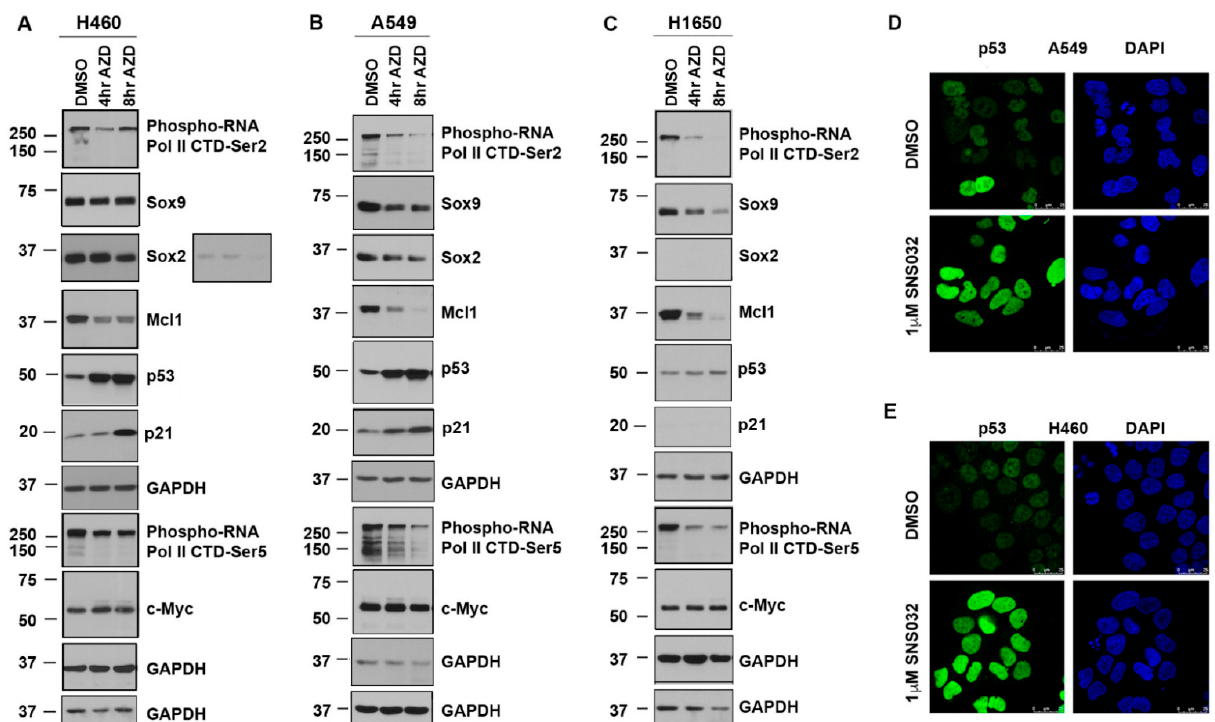
Figure 2. CDK9 inhibitors suppress Mcl1, Sox2, and Sox9 and enhance p53 expression in lung cancer cells: ( A – C ) H460, A549, and H1650 cells were treated with AZD4573 at 20 nM for 4 and 8 h and samples were analyzed by western blotting. Blots probed with the Phospho-Ser2-RNA Pol II CTD antibody show a decrease in the phosphorylation levels in A549 and H1650 cells, and to a lesser extent in H460 cells, indicative of CDK9 inhibition. Ser5-specific phosphorylation also showed a decrease in H460, A549, and H1650 cells, with H460 showing lesser effect. AZD4573 treatment led to a reduction in the levels of Mcl1 in H460, A549, and H1650 cells. Similarly, AZD4573 treatment showed a better reduction in the expression of Sox9 in A549 and H1650 cells compared to H460 cells. Sox2 reduction was more visible in A549 than H460 (both dark and light exposure for Sox2 in H460 is shown); H1650 did not show any detectable levels of Sox2. Analysis of the blots using a p53 antibody showed marked increase in its levels in H460 and A549 cells; H1650 did not show any visible changes. Both H460 and A549 cells also showed an increase in p21 levels. AZD4573 did not affect the levels of c-Myc in the cells. Blots were re-probed with GAPDH antibody for normalization. ( D ) A549 and ( E ) H460 cells were treated with SNS032 at 1 µ M for 24 h and immunofluorescence analysis was conducted using a p53 antibody. Results show a drastic increase in p53 levels upon treatment with CDK9 inhibitor compared to the DMSO vehicle treated